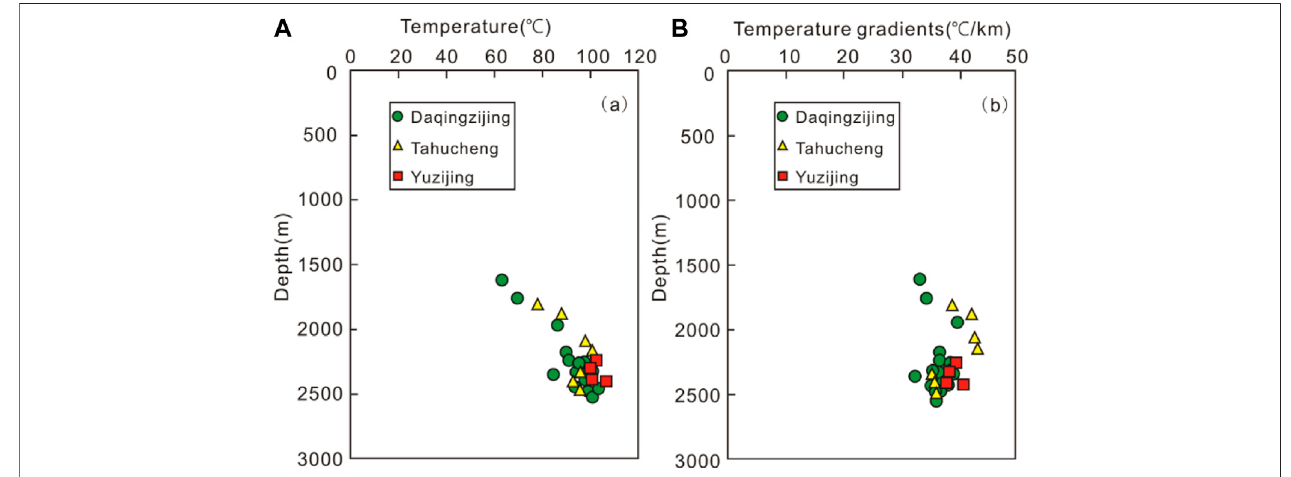
TABLE 2 | Results of temperature, geothermal gradient, and heat fl ow in the southern part of the Songliao Basin. Tectonic unit Daqingzijing